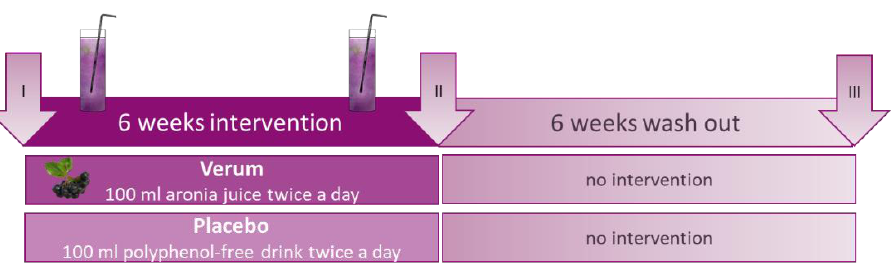
Figure 1. Study design: the participants were investigated at three time points at baseline (I), after the intervention period of six weeks (II), and after another six weeks of washout (III) to observe any potential persistent effects of the intervention. The participants were asked to consume 100 mL of the aronia juice or the polyphenol-free placebo drink, respectively, twice a day for six weeks. The study participants were allocated randomly to the verum group (V) who drank the aronia juice and the placebo group (P) who drank a completely polyphenol-free placebo drink. The aronia juice was derived from a local producer and the polyphenol-free placebo drink was prepared in accordance with a published recipe [27]. The nutrient profile of the placebo drink was comparable to the natural juice except for the polyphenol